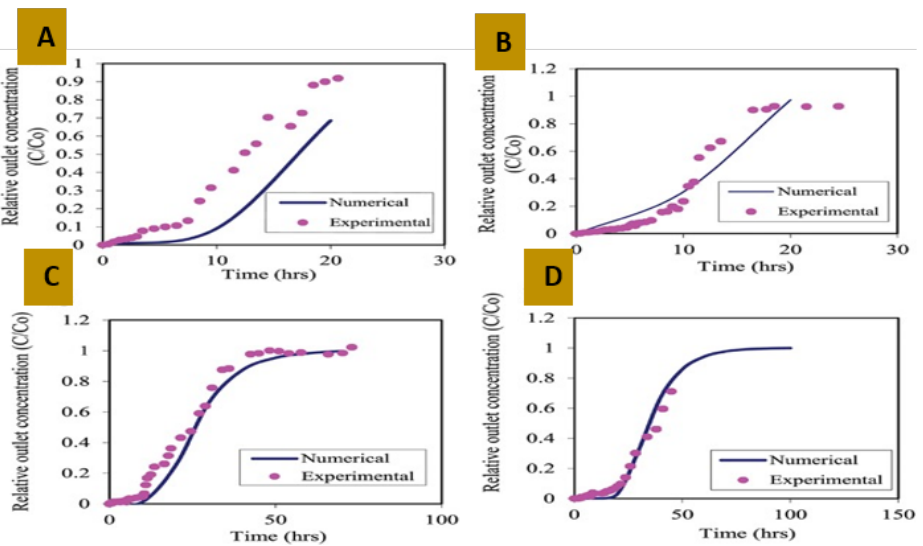
Figure 3. Comparison of experimental and numerical results of As(III) removal in codfish scale- packed columns: ( A ) Run 1: Mass of adsorbent = 61.54 g of dried cod scales, concentration of arsenic (III) solution = 41,220 mg/L, pH = 8.7 and flowrate to the column = 2 mL/min. ( B ) Run 2: Mass of adsorbent = 66.87 g of dried cod scales, concentration of arsenic (III) solution = 82,760 mg/L, pH = 9.25 and flowrate to the column = 2.75 mL/min. ( C ). Mass of adsorbent = 66.87 g of dried cod scales, concentration of arsenic (III) solution = 41,220 mg/L, pH = 9.25 and flowrate to the column = 2.75 mL/min. ( D ) Run 4: Mass of adsorbent = 69.544 g of dried cod scales, concentration of arsenic (III) solution = 520 mg/L, pH = 8.7 and flowrate to the column = 2 mL/min, adapted with permission from Ref. [116]. 2015, John Wiley and Sons.